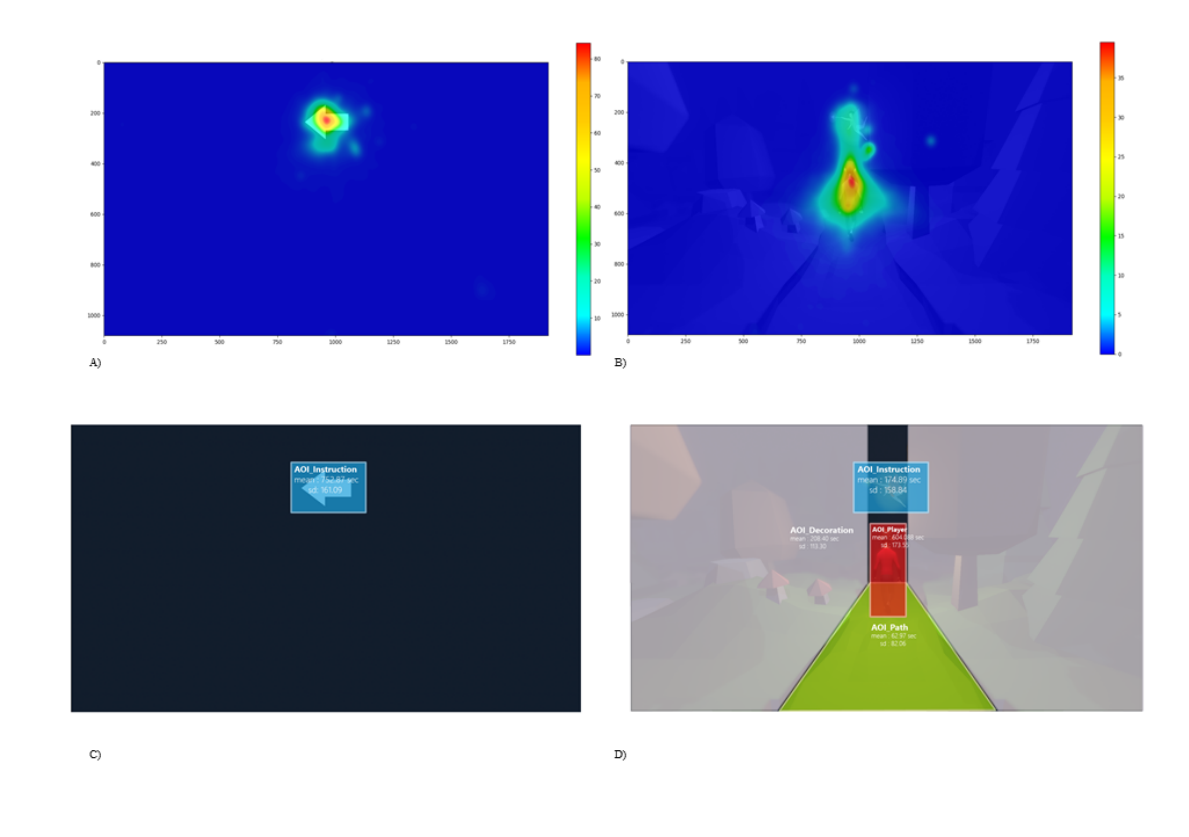
Table 8. Mean scale values for each Intrinsic Motivation Inventory subscale depending on task variant and the study.